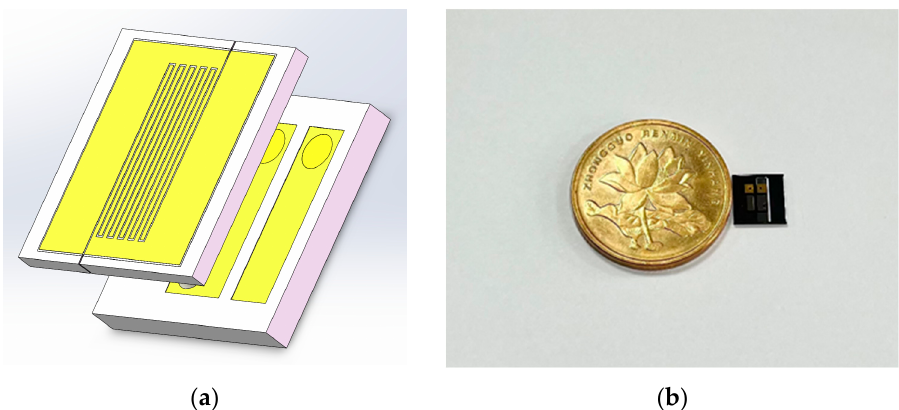
Figure 7. The optical image of MEMS structure. Figure 7. ( a – g ) The optical image of MEMS structure.